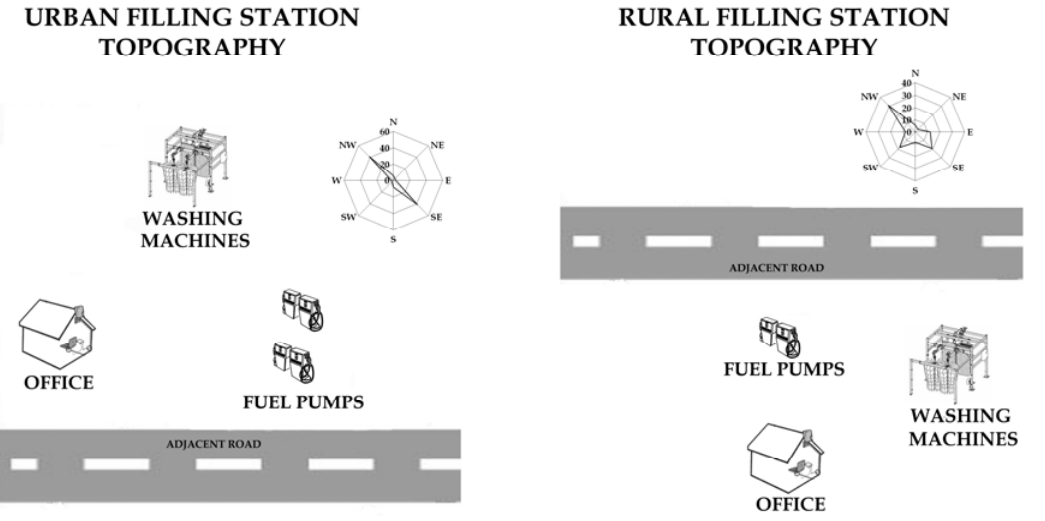
Figure 2 . Topography of the filling stations in combination to the prevailing